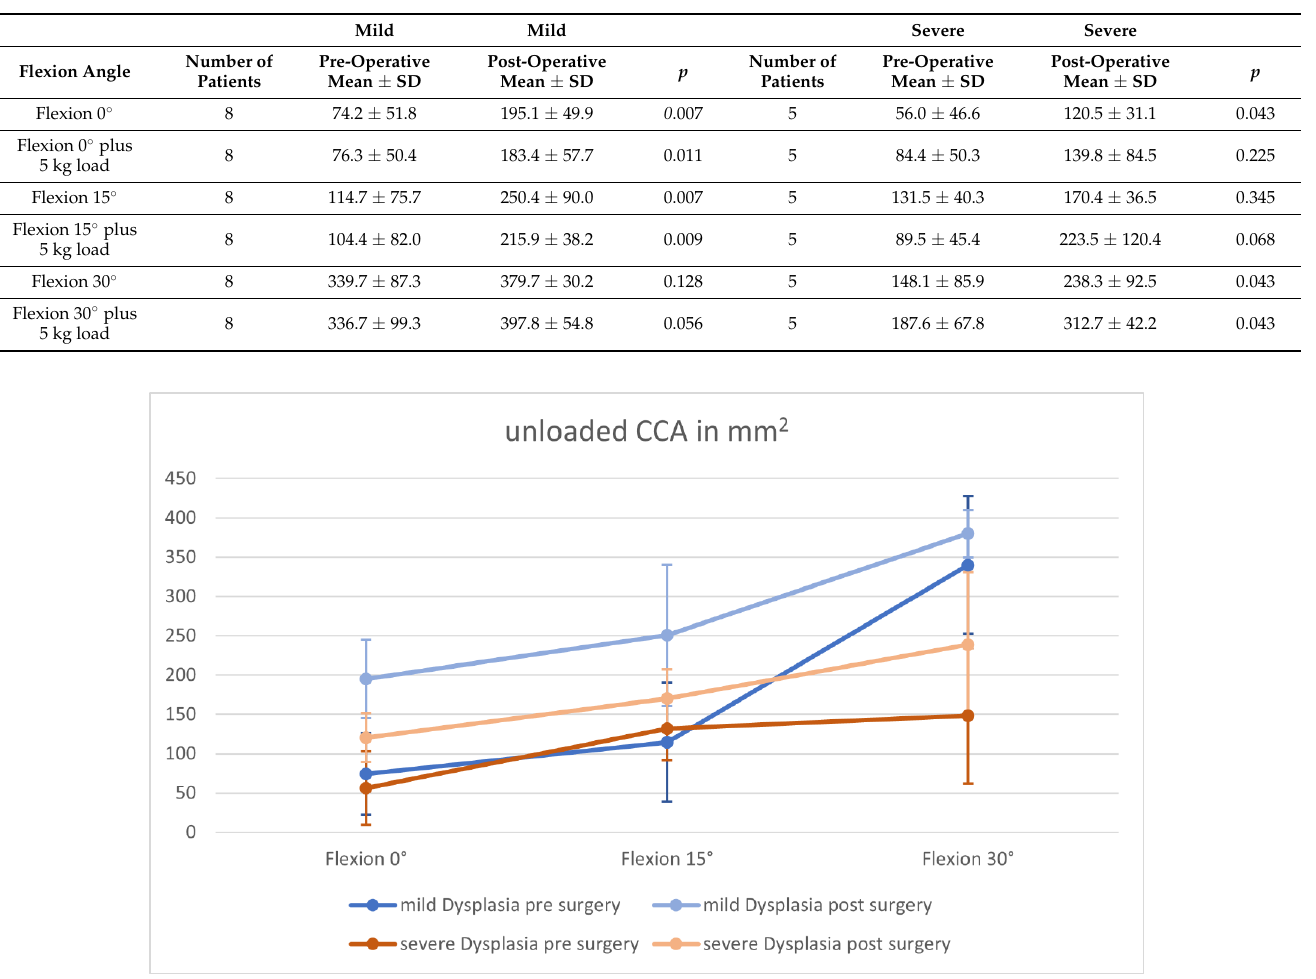
Table 3. Cartilage contact area in mm 2 .